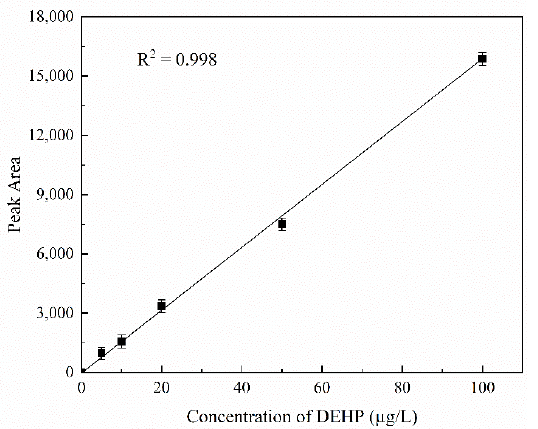
Figure 6. Detection of DEHP in aquatic wastewater samples. Standard curve of the DEHP standard at concentrations of 0, 5, 10, 20, 50, and 100